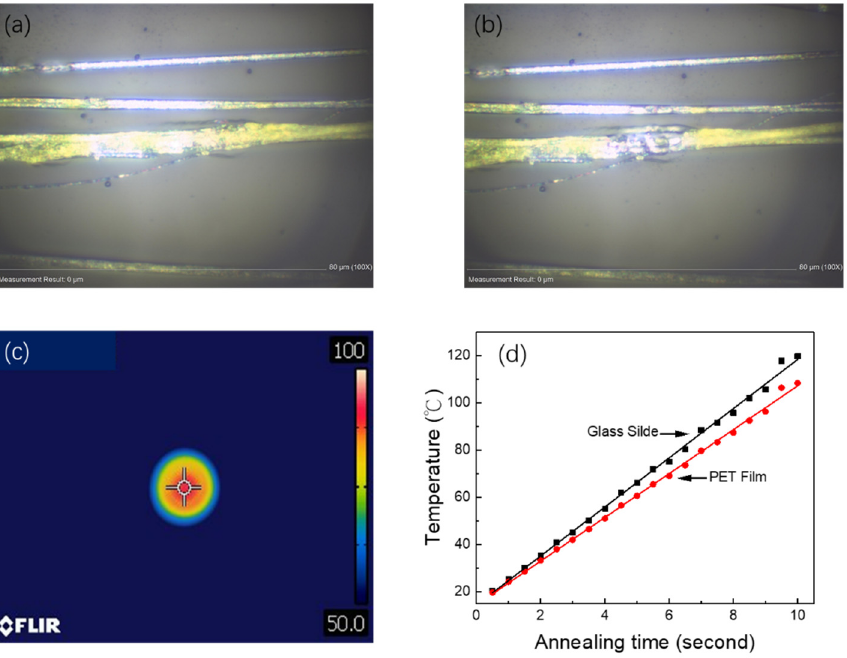
Figure 3. The OM image of a perovskite film ( a ) before and ( b ) after the laser beam illumination. A violet laser beam was focused by a 100X objective lens on the perovskite film. The laser beam di- ameter was measured as 2.6 μ m. ( c ) The thermal image pictured by a thermal infrared camera due to laser beam illumination.( d ) The heating curve with